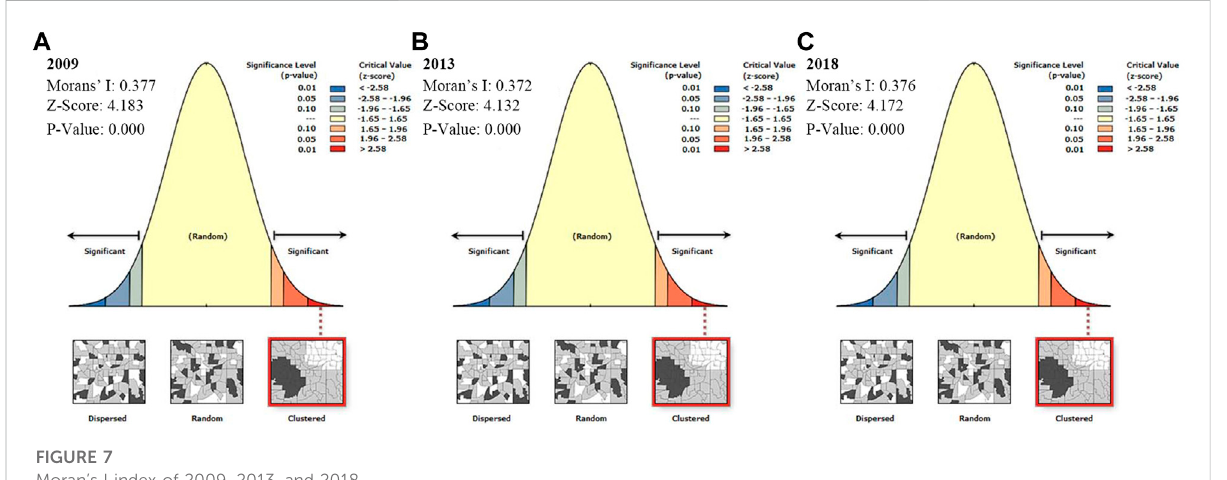
FIGURE 7 Moran ’ s I index of 2009, 2013, and